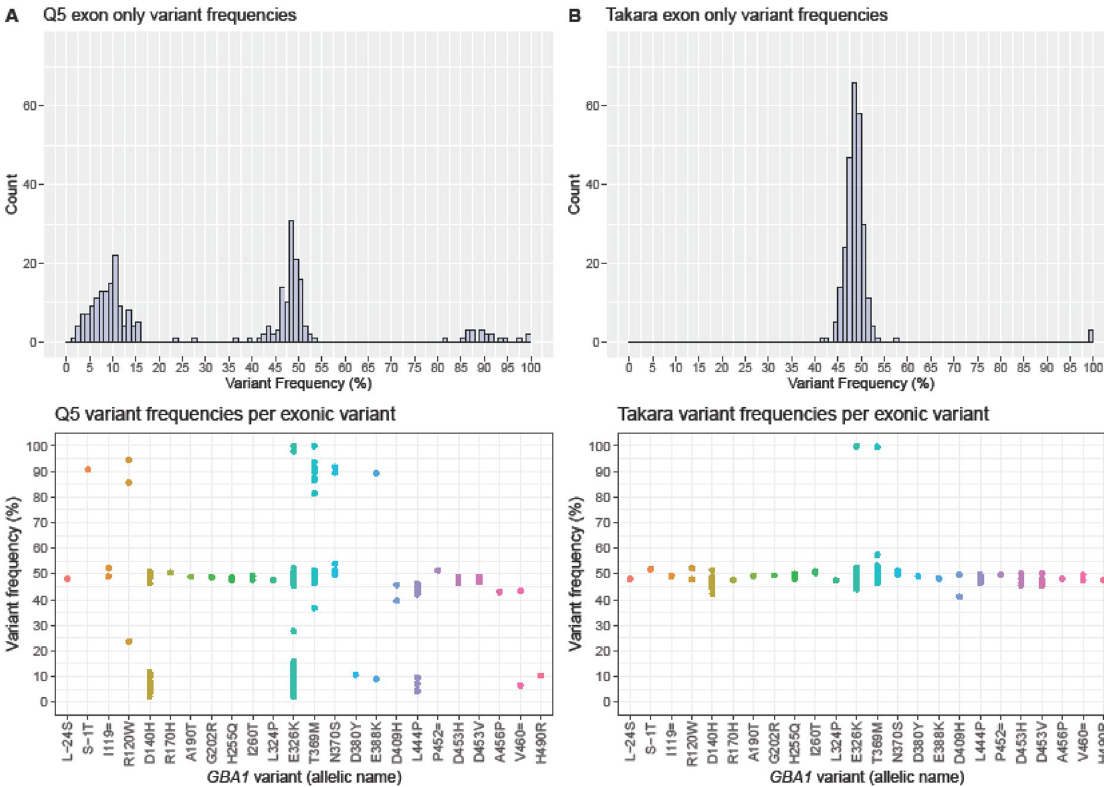
Figure 1. Comparison of exonic variant frequencies using ( A ) Q5 polymerase or using ( B ) TaKaRa polymerase. These are the first 216 samples with a suspected GBA1 exonic variant, initially sequenced using the Q5 polymerase and later repeated with TaKaRa polymerase. The top row shows histograms combining all exonic variants. The bottom row shows dot plots with variant frequencies per specific exonic variant. In normal circumstances, one would only expect a variant frequency around 50% and 100%. 44 samples contained two exonic variants (primarly p.[Asp179His;Glu365Lys] (D140H + E326K)), one sample contained three